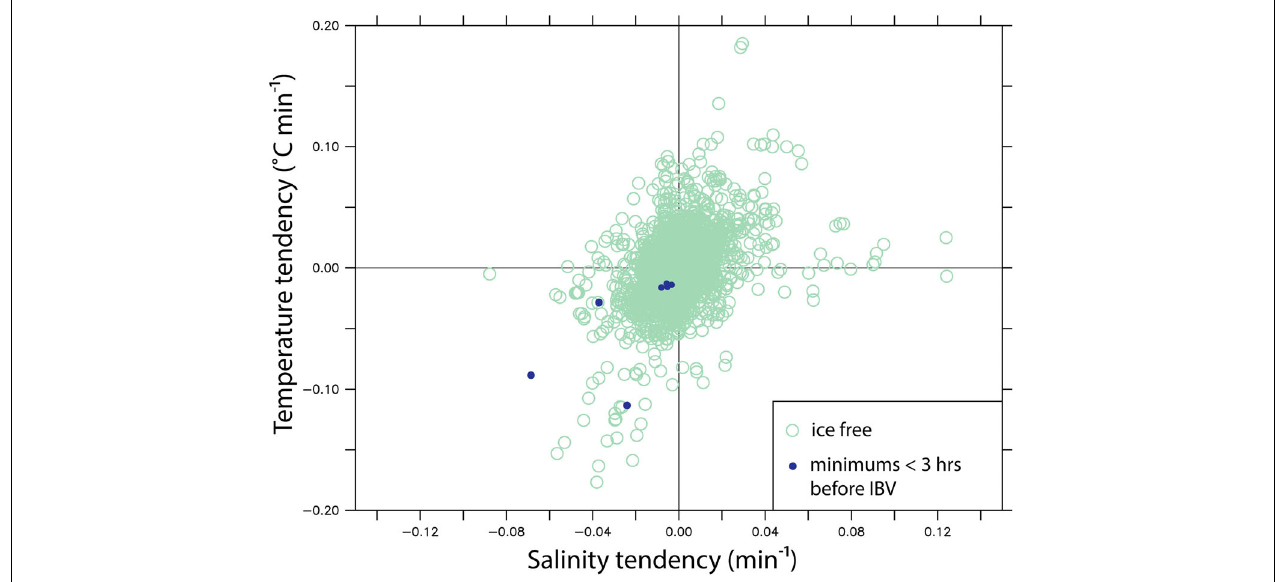
FIGURE 14 | The temperature and salinity tendencies observed while sd-1036 sampled ISSI = 0 conditions (no ice in saildrone images) are plotted with open circles, based on differences between 5 min averages separated by 20 min. The largest negative tendencies observed en route to ice (see Table 1 ) are plotted with